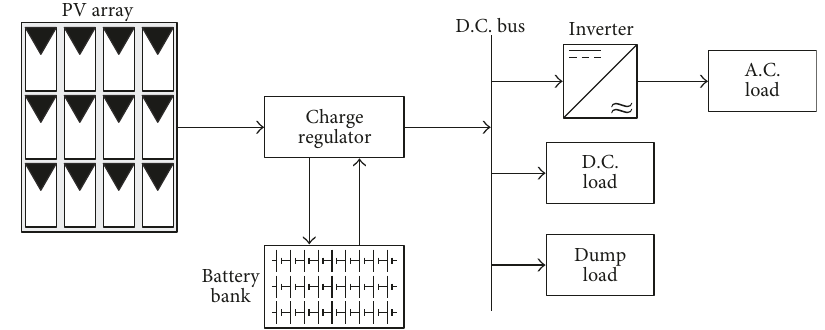
Figure 1: Basic components of SAPV plant. Table 1: Constant values of SAPV system